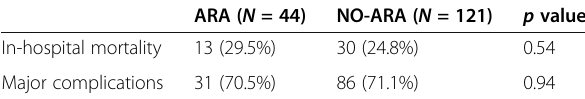
Table 4 In-hospital mortality and major complications in surgically treated patients in both groups, N